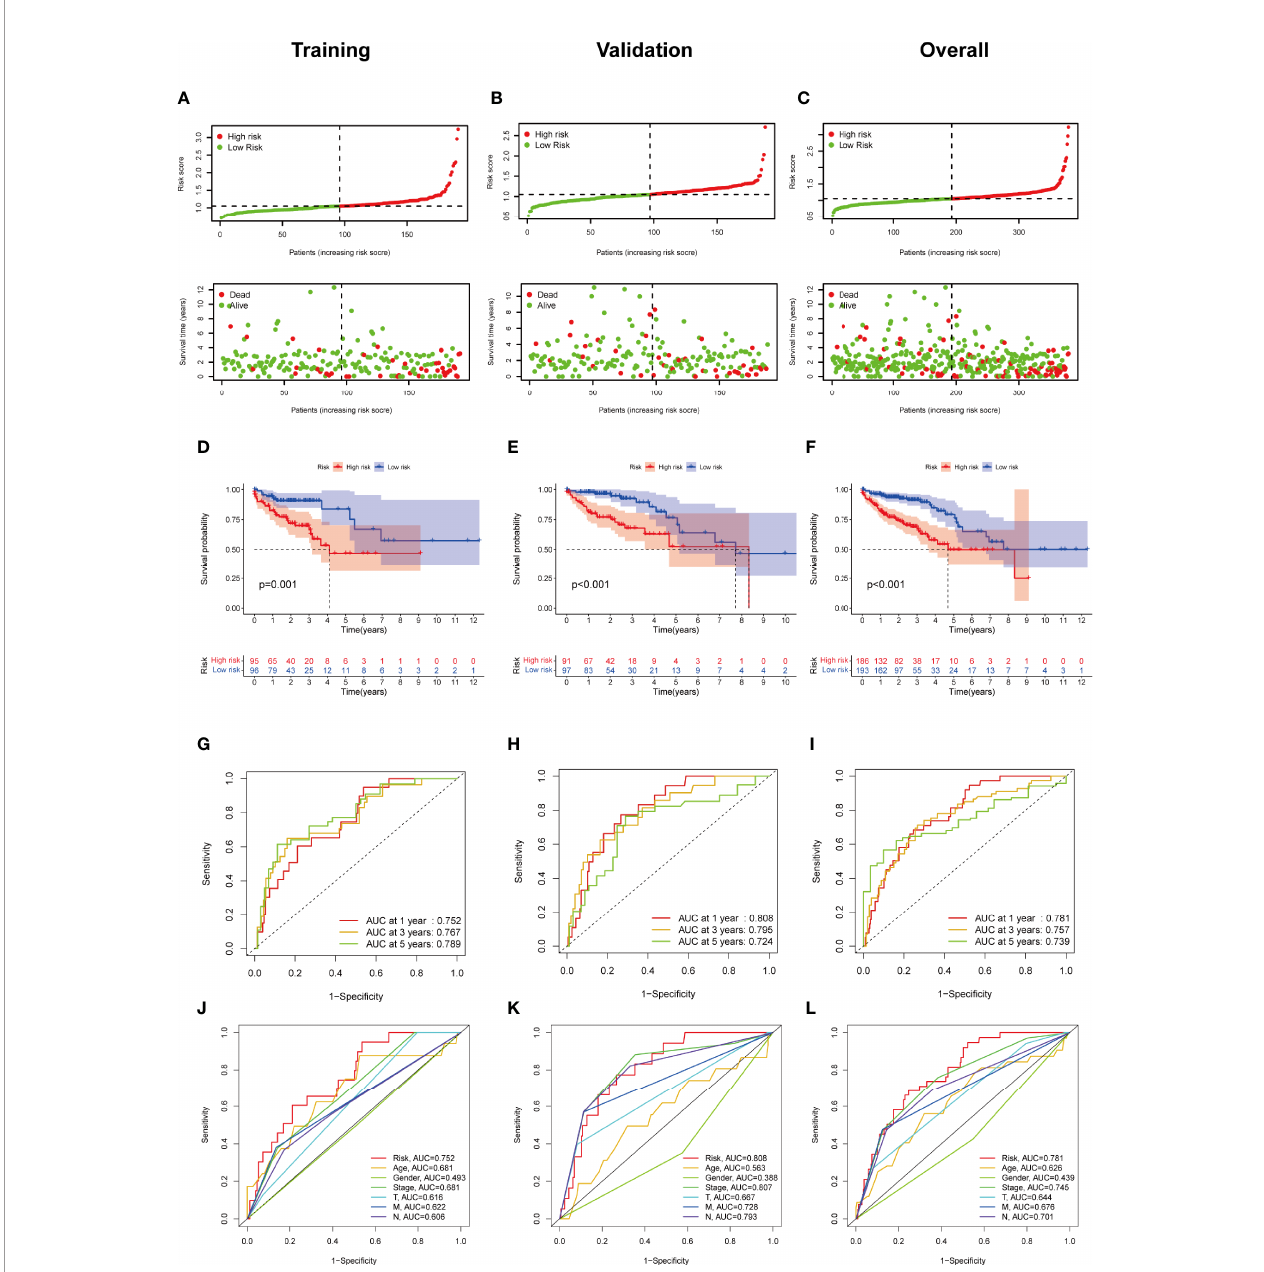
FIGURE 4 | Construction and validation of the ferroptosis-related lncRNA signature model in the training cohort, validation and overall groups. (A – C) The distribution of the risk scores and the distributions of overall survival status and risk score in the training, validation and overall groups. (D – F) The Kaplan – Meier curves for survival status and survival time in the training, validation and overall groups. (G – I) The receiver operating characteristic (ROC) curve shows the potential of the prognostic ferroptosis-related lncRNAs signature in predicting 1-, 2-, and 3-year overall survival (OS) in the training, validation and overall groups. (J – L) AUC of ROC curves comparing the prognostic accuracy of the risk score and other prognostic factors in the training, validation and overall